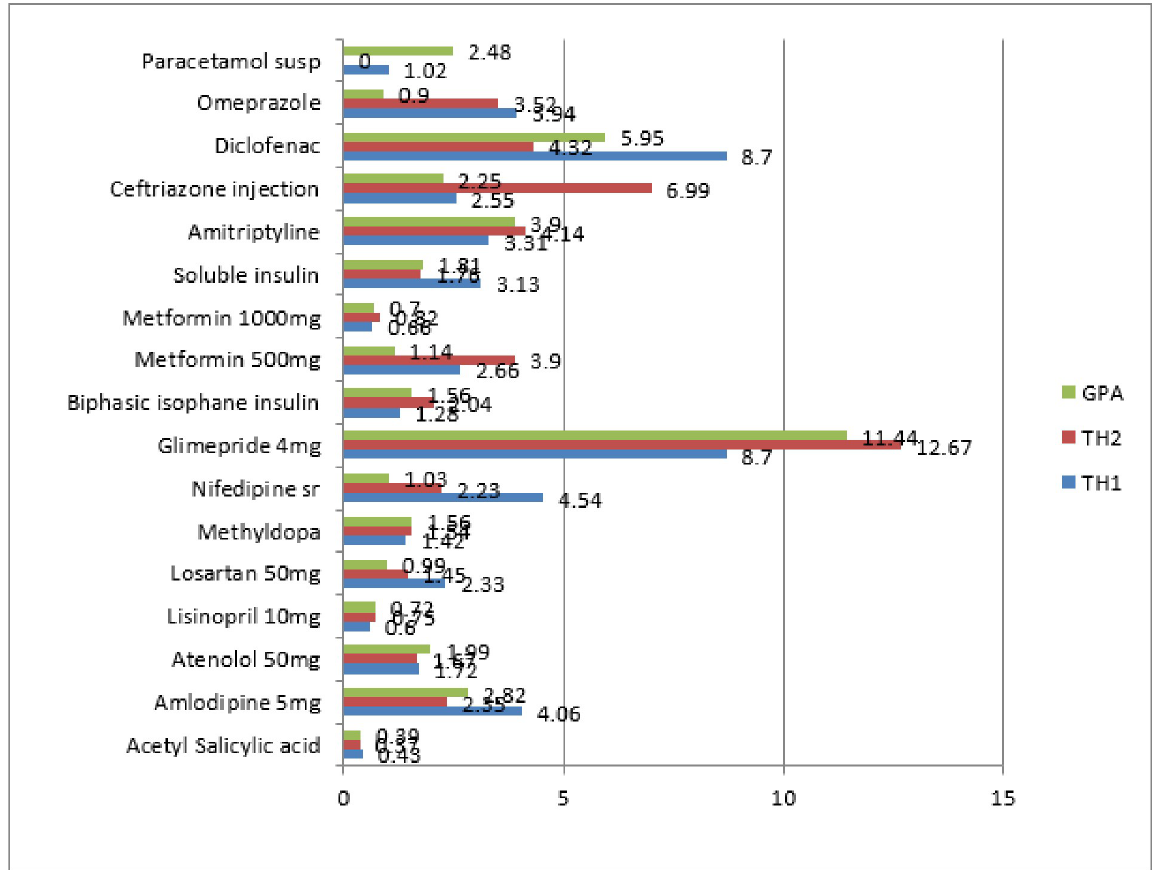
Fig 2. Procurement prices for generic medicines in Abuja. GPA = Government procurement Agency, TH1 = Tertiary Hospital 1, TH2 = Tertiary Hospital